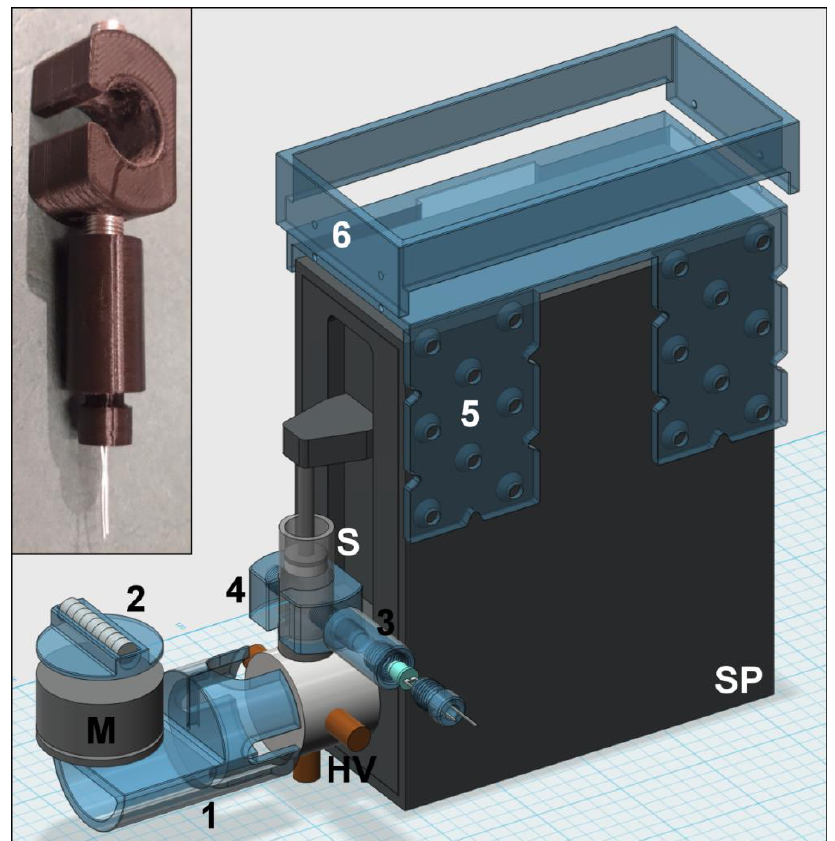
Figure 4. Lab-In-Syringe system from a syringe pump (SP) with 3 port head valve (HV) with an upside-down orientated syringe (S). 3D printed elements are shown in blue color and disassembled, required screws are not shown. A removable adaptor for the head valve (1) allows the positioning of the motor (M) close to the syringe. A holder for NdFeB magnets (2) is glued on-top that induce stirring bar rotation inside the syringe at the motor start. A LED holder (3) is screwed onto a fiber-optic adaptor (4) that is placed onto the glass barrel for in-syringe photometric measurements (Photometer and optical fibers not shown). Elements 5 and 6 compose a tray and universal support for deposition of tools (fittings, screwdriver, etc.) and to attach further items, e.g., the relay board for motor control. The photo shows the 3D printed elements 3 and 4 for in-syringe